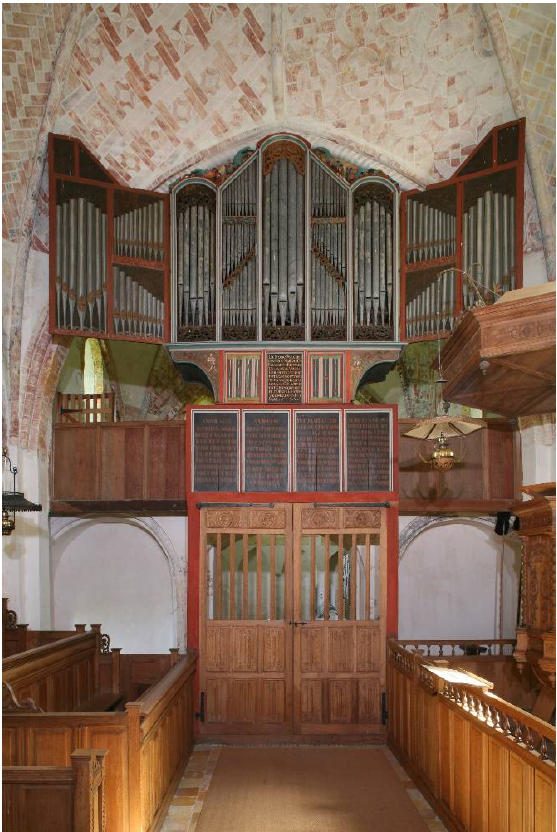
Figure 3. The rood loft (c. 1300) and organ (1531) in the small parish church of Krewerd (Groningen) reflect monastic church interiors (photo: Regnerus Steensma archive).